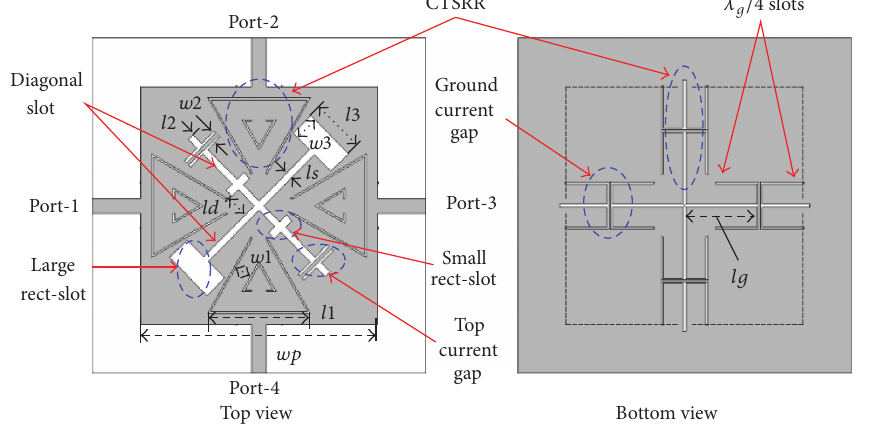
Figure 1: Top and bottom view of the proposed patch coupler.